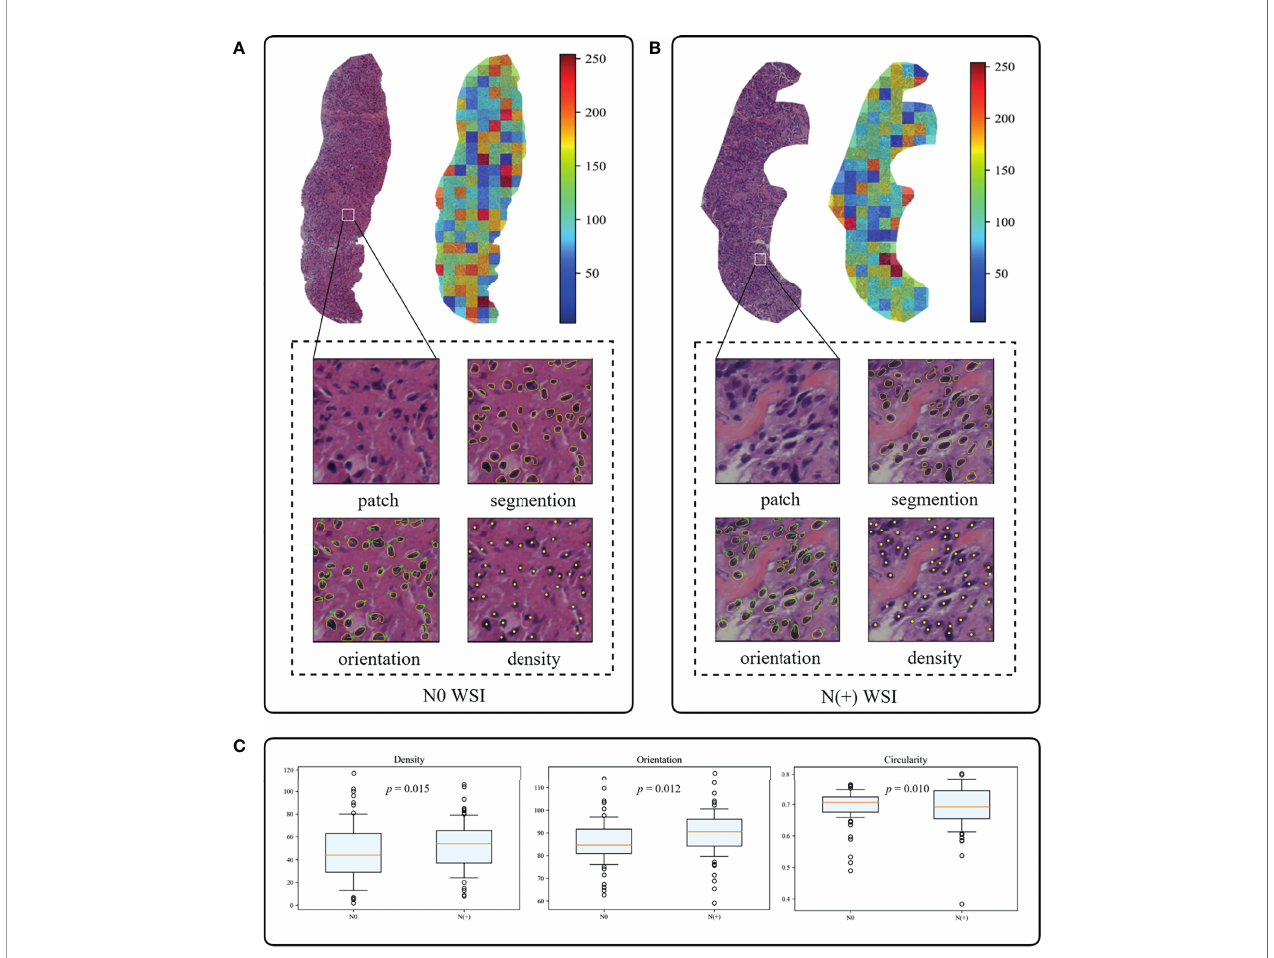
FIGURE 6 | The interpretability of the deep learning core-needle biopsy (DL-CNB) model of two patients. (A, B) The heat maps and nuclear segmentation from core-needle biopsy (CNB) whole-slide images (WSIs) of the N0 and the N(+) separately, and the red regions show greater contribution to the fi nal classi fi cation. (C) The statistical analysis of three nuclear characteristics most relevant to diagnosis of all